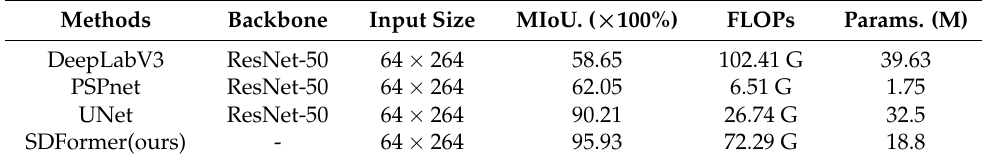
Table 2. Result on Sleeper beam dataset.